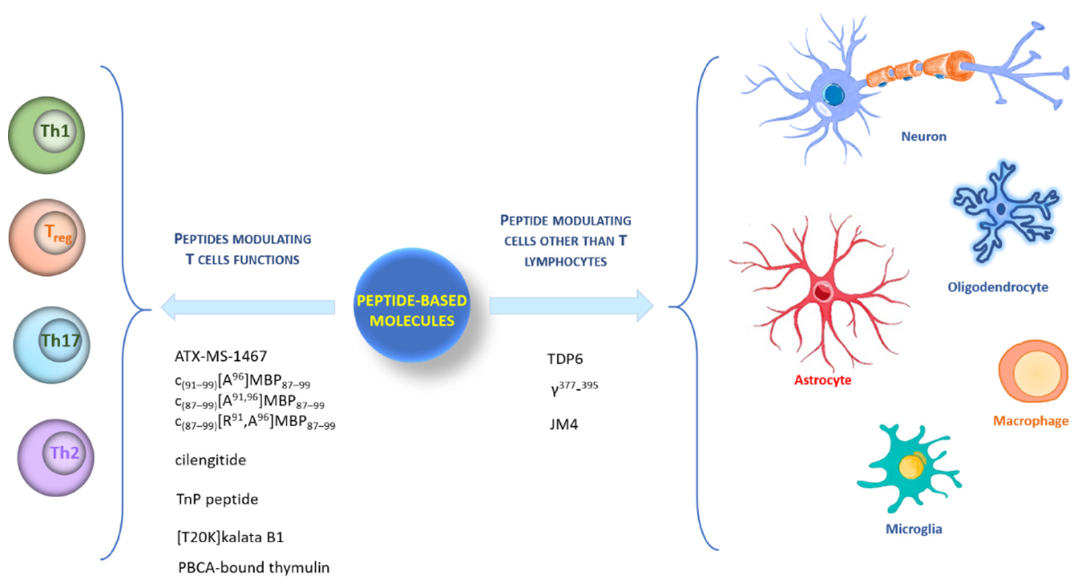
Figure 1. Graphic representation of different type of cells targeted by peptides.